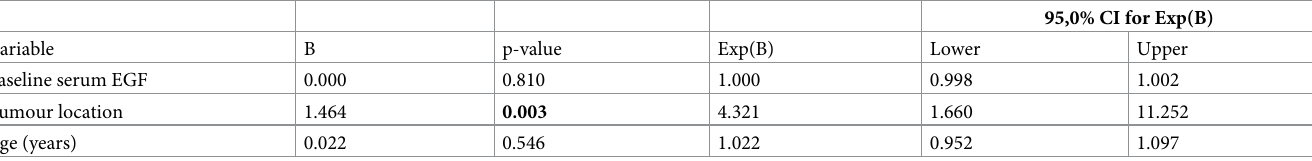
Table 3. The impact of age, tumour location and serum EGF on overall survival of oncological patients.